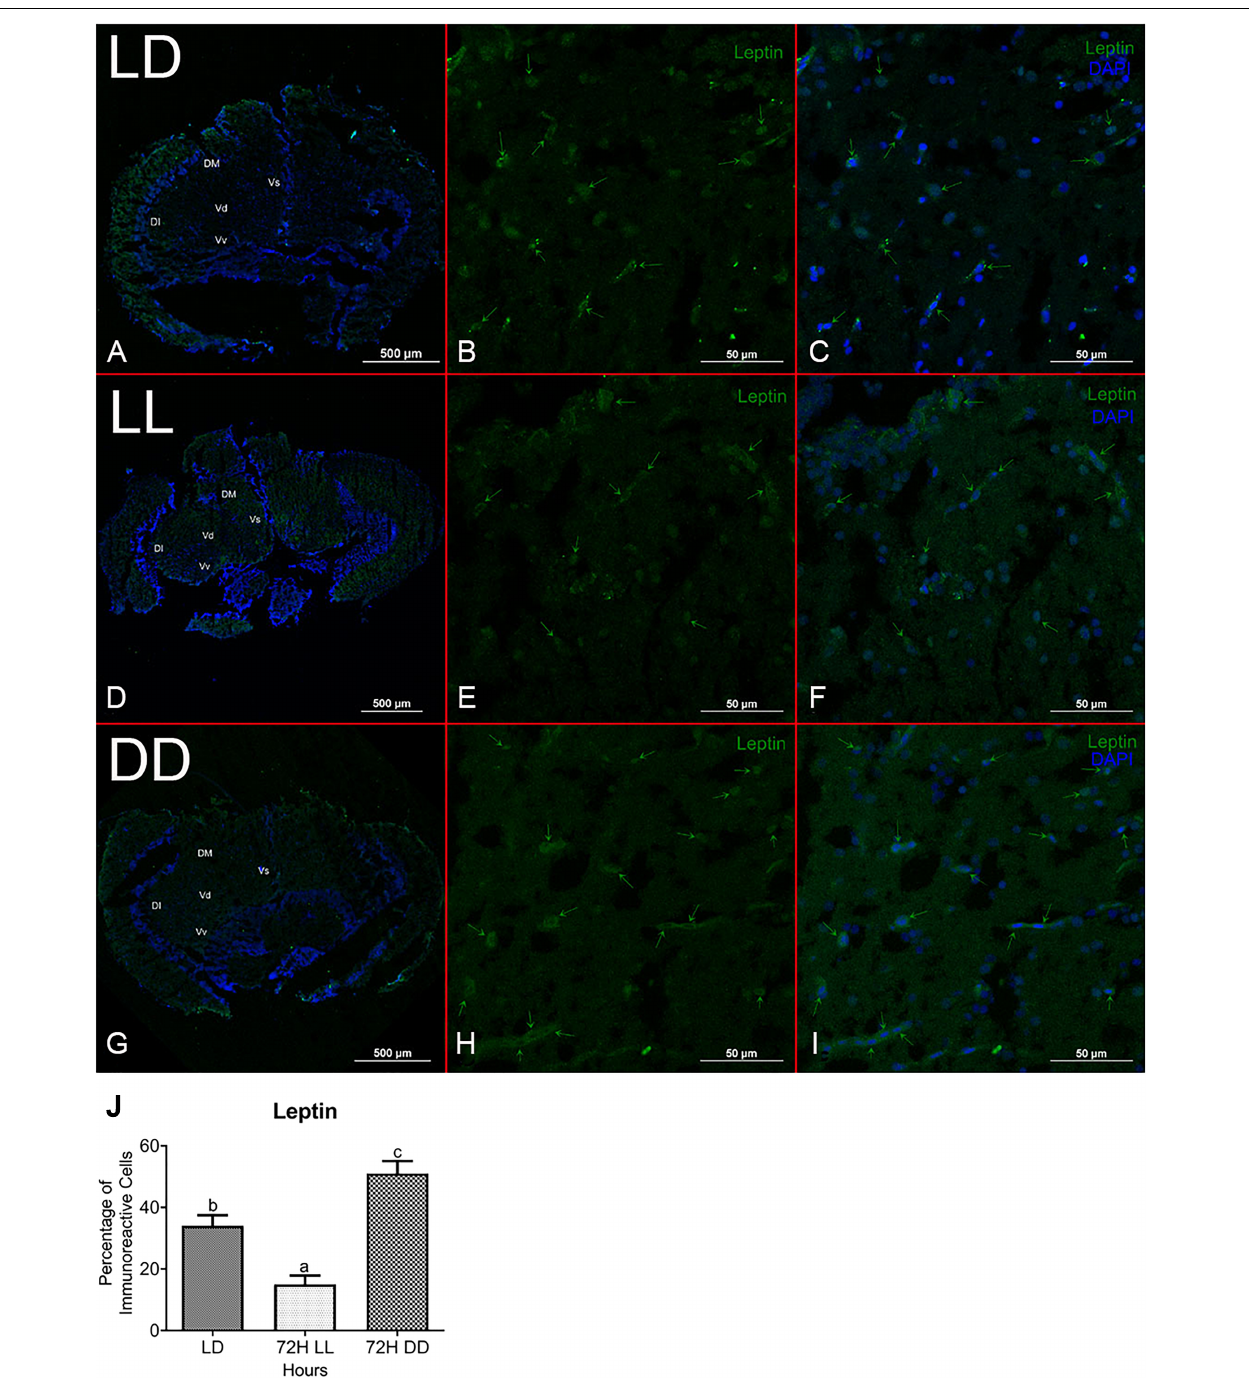
FIGURE 4 | Localization and characterization of Leptin in zebrafish brain under different photic conditions (LD, LL, and DD). The figure shows Leptin immunoreactivity cells in LD (B) , LL (E) , and DD (H) in the telencephalon region of the brain in zebrafish. Immunohistochemical localization shows Leptin immunoreactive cells (green arrow) in the dorsomedial, dorsolateral, and ventromedial zone of the telencephalon in the brain. The whole section of brain through telencephalic region (A,D,G) , Leptin-positive cells (green) (B,E,H) , and merge imaged with nuclear stain DAPI (C,F,I) . Relative abundance of Leptin immunopositive cells in the brain under different photic conditions. The relative quantification values in the graph are shown as the mean ± SEM ( n = 5). Different letters indicate significant differences evaluated by one-way ANOVA [ F (2,6) = 26.536, p = 0.001] followed by post-hoc Tukey’s test ( p < 0.05) (J) . For the percentage calculation method, please consult the section “Materials and Methods. ” Representative images were taken from multiple sections of five separate zebrafish brain in each experimental condition (Vs, supracommissural nucleus; Vd, dorsal nucleus; Vv, ventral nucleus of ventromedial telencephalon).